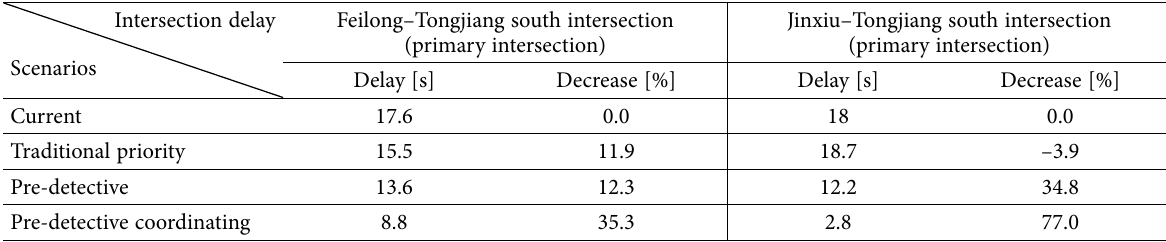
Table 2. Average intersection delay of each